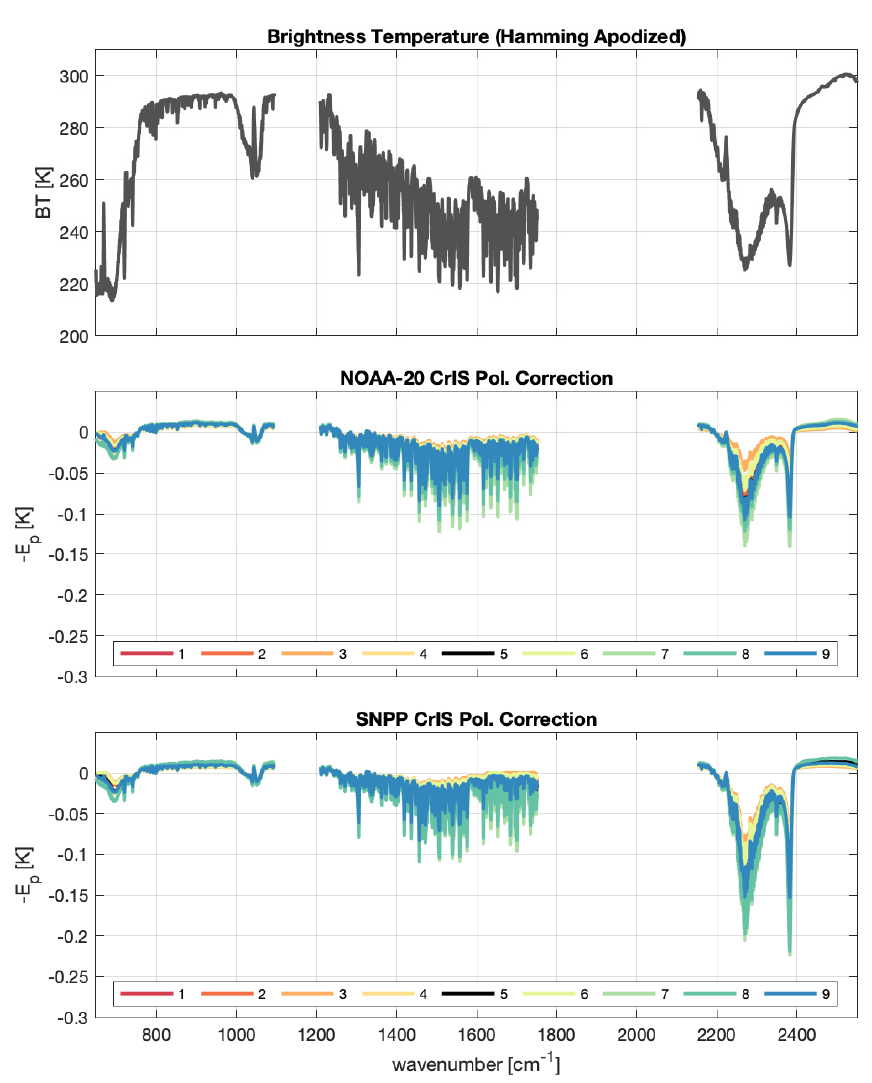
Figure 18. FOV and sensor dependence of the polarization correction for an example of a tropical atmosphere over ocean.